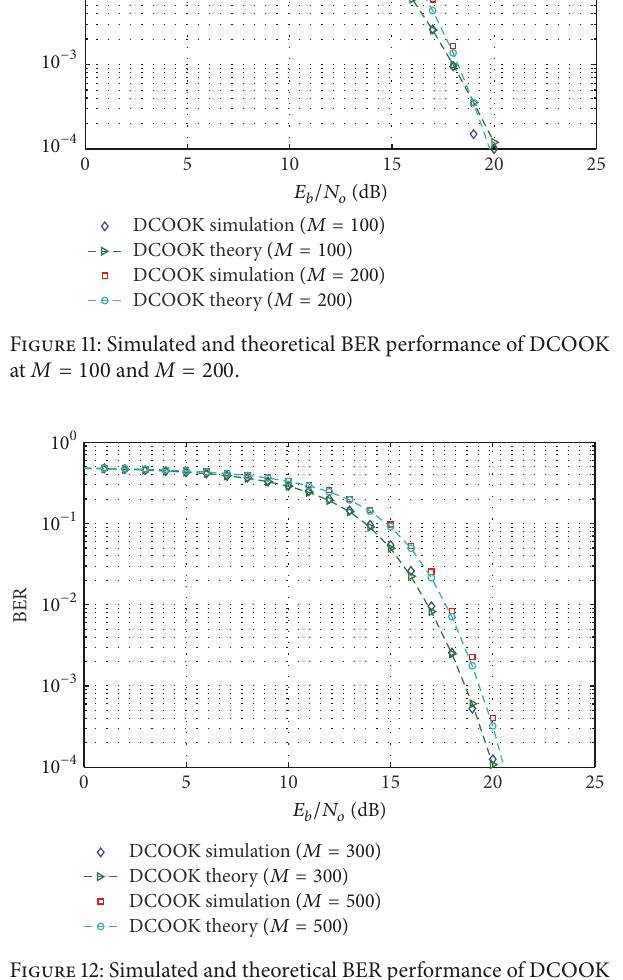
Figure 12: Simulated and theoretical BER performance of DCOOK at 𝑀 = 300 and 𝑀 = 500